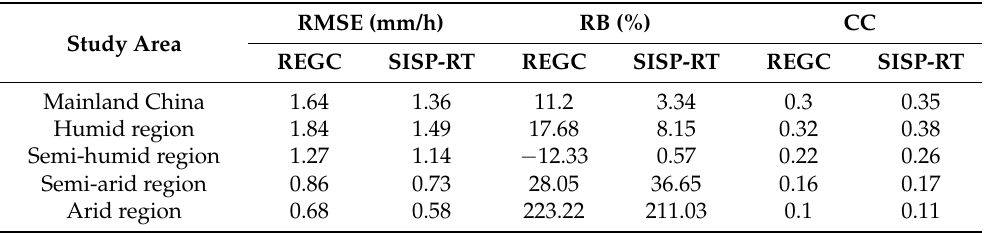
Table 2. The summary of the three evaluation indices (RMSE, RB, and CC) for the REGC and SISP-RT for the summers.